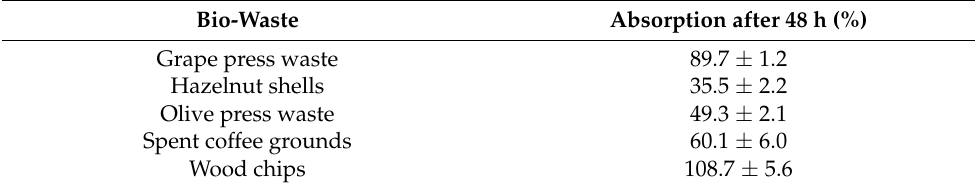
Figure 6. Water absorption as a function of time, tested according to Amziane et al. [30]. Table 6. Water absorption of the bio-wastes after 48 h of